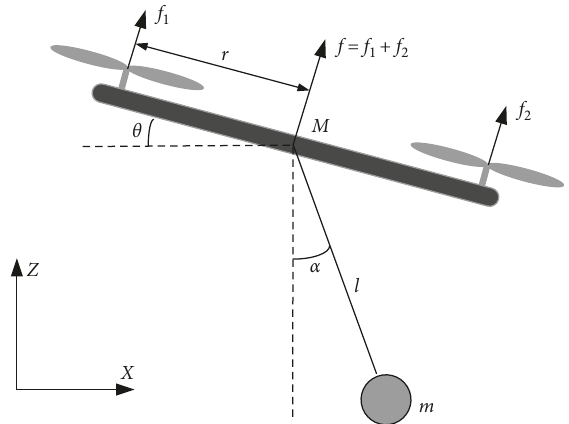
Figure 1: Quadrotor transporting a payload in the X-Z